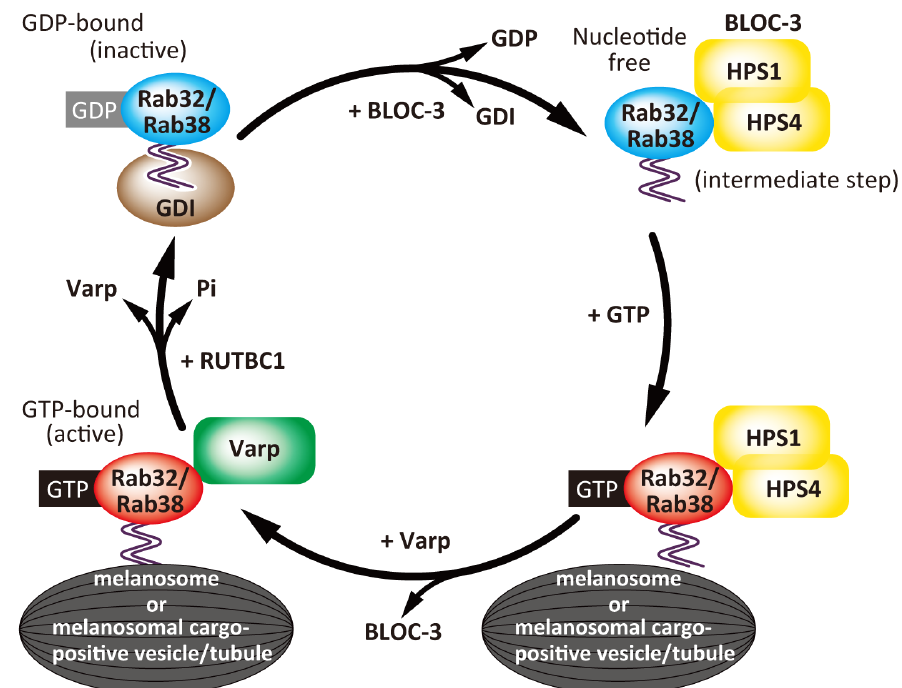
Figure 2. Diagram of Rab activation and inactivation during membrane traffic. Rabs are a subgroup of Ras-like small GTPases and are switch molecules that cycle between a GDP-binding inactive form and a GTP-binding active form. In this figure, Rab activation and inactivation mechanisms are shown by using Rab32 and Rab38 as examples. GDP-binding inactive Rab32 and Rab38 are present in the cytosol in complex with a GDI. BLOC-3 is a Rab32/Rab38-GEF that removes GDP from the GDP-Rab32/Rab38 and promotes their GTP binding, which converts Rab32/Rab38 to their active form. At the same time, Rab32/Rab38 are localized to the intracellular membrane surface by means of a geranylgeranyl group attached to the C-terminal cysteine residues of Rab32/Rab38. Active Rab32/Rab38 interact with one of their effector molecules, Varp, and regulate membrane trafficking, such as melanosomal cargo transport. The Rab32/Rab38-GAP RUTBC1 then activates the intrinsic GTPase activity of Rab32/Rab38, thereby hydrolyzing their GTP, and returning them to inactive GDP-Rab32/Rab38. BLOC, biogenesis of lysosome-related organelles complex; GAP, GTPase-activating protein; GDI, GDP dissociation inhibitor; GEF, guanine nucleotide exchange factor; HPS, Hermansky–Pudlak syndrome; RUTBC1, RUN and TBC1 domain-containing protein 1; Varp, VPS9-ankyrin- repeat